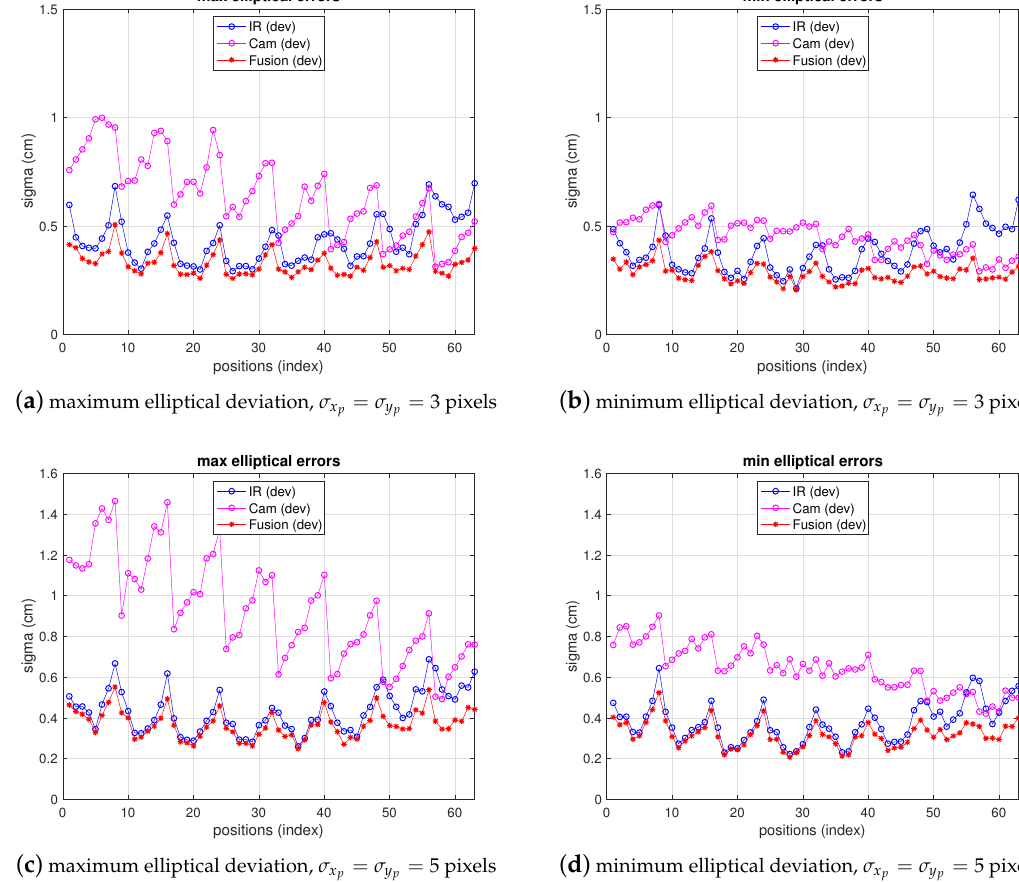
Figure 6. Fusion simulation